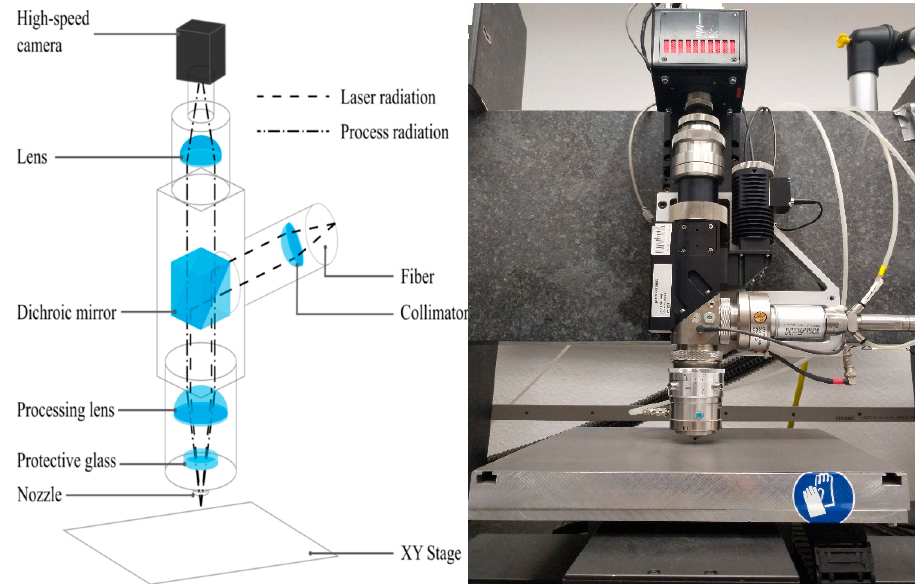
Figure 1. Optical setup of the cutting head (left) and image of the system (right).